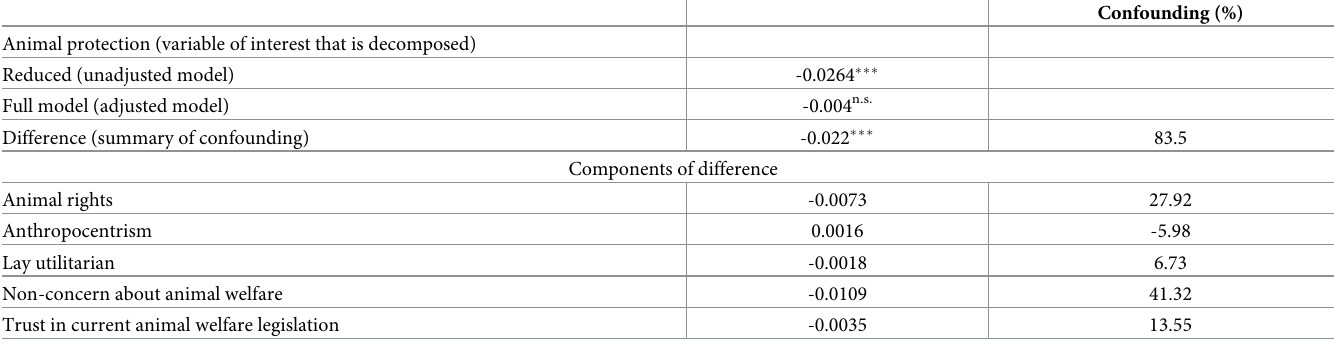
Table 6. Decomposition of the extent to which five variables (Animal rights, Anthropocentrism, Lay utilitarian, Non-concern, and Trust in current animal welfare legislation) mediate the effect of the Animal protection orientation on Animal welfare-friendly meat consumption (N = 976) A,B